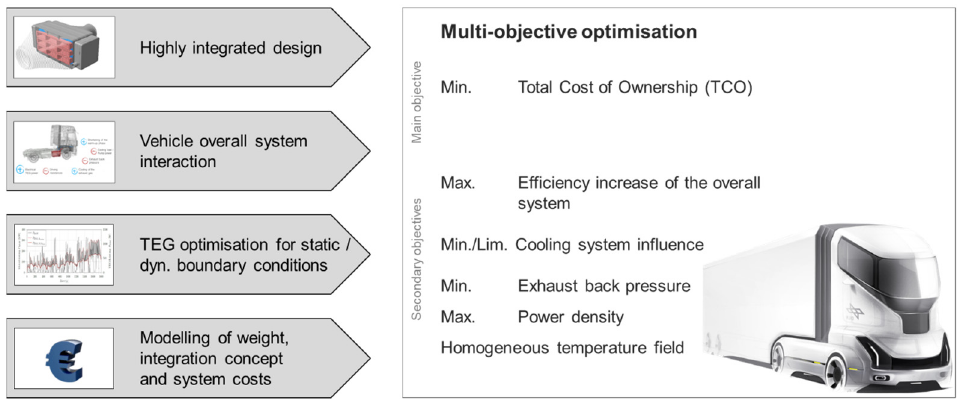
Figure 1. Development approach for TEG systems based on multi-objective optimization and consideration of the overall vehicle interaction as well as holistic design criteria.